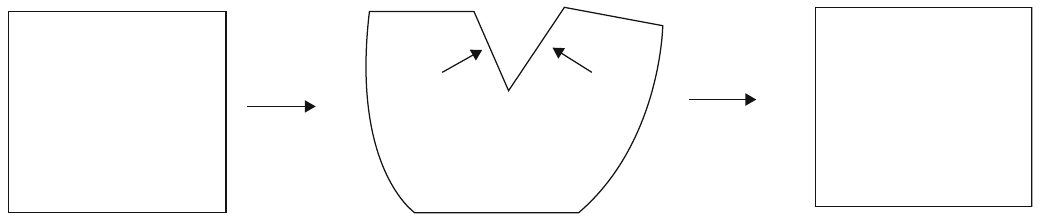
Figure 17: When a crack or similar damage occurs to a shape memory polymer capable of self-healing through physical means, if the polymer can be made to physically close the crack by means of a wire or the surface bending the polymer shut, and heat is applied, the polymer can then self-heal and repair the damage, resuming its former shape with minimal loss of